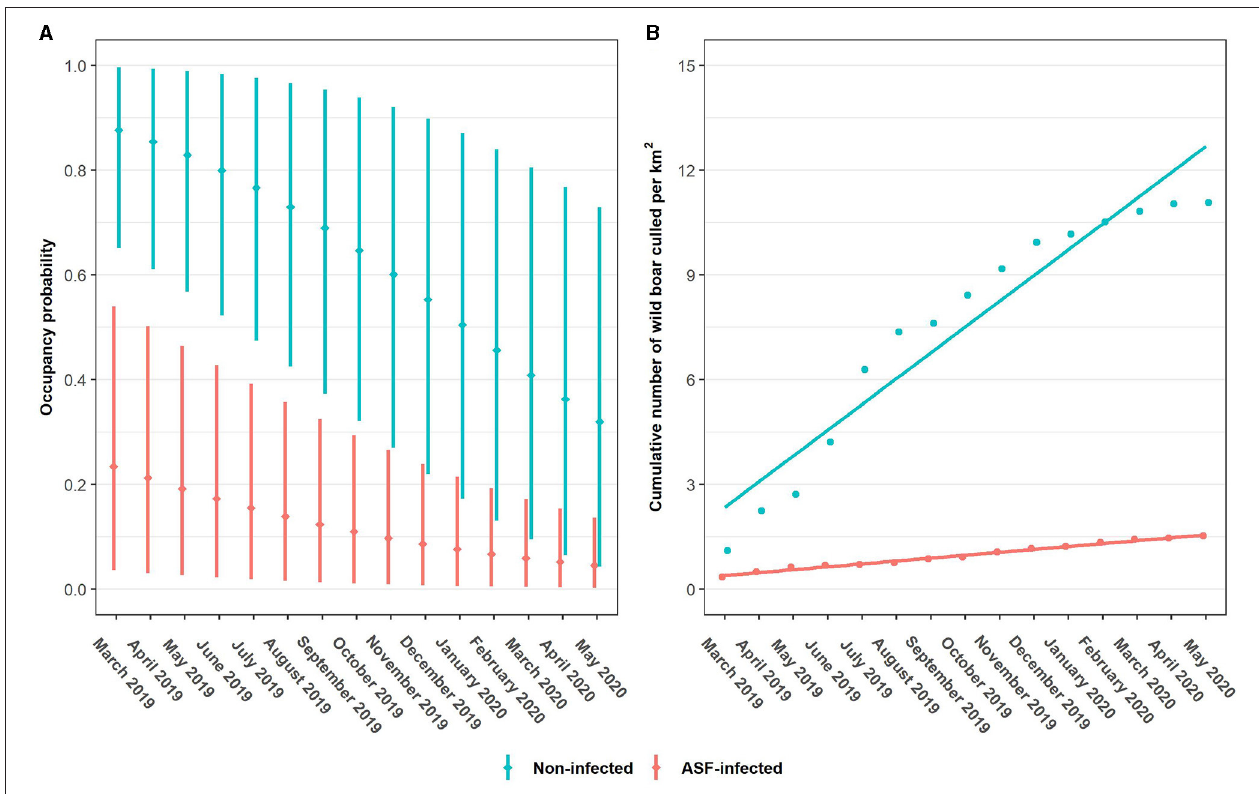
FIGURE 2 | Monthly posterior mean occupancy estimates (dots) and 95% highest posterior density intervals (vertical lines) per ASF management zone (A) . Cumulative number of wild boar culled per km 2 in function of the observation month. Trend lines derived from ordinary least squares regression estimation (B)